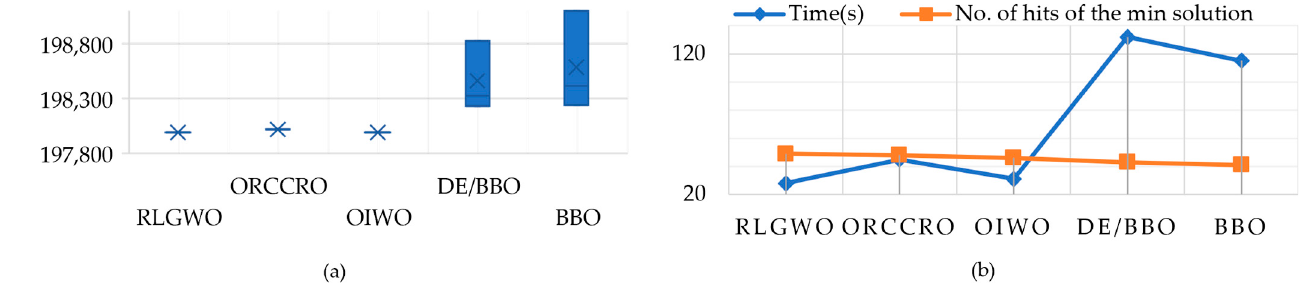
Figure 9. Results for different methods for the 110-unit system (50 trials): ( a ) boxplot of the final generation cost; ( b ) time and number of hits of the minimum solution.